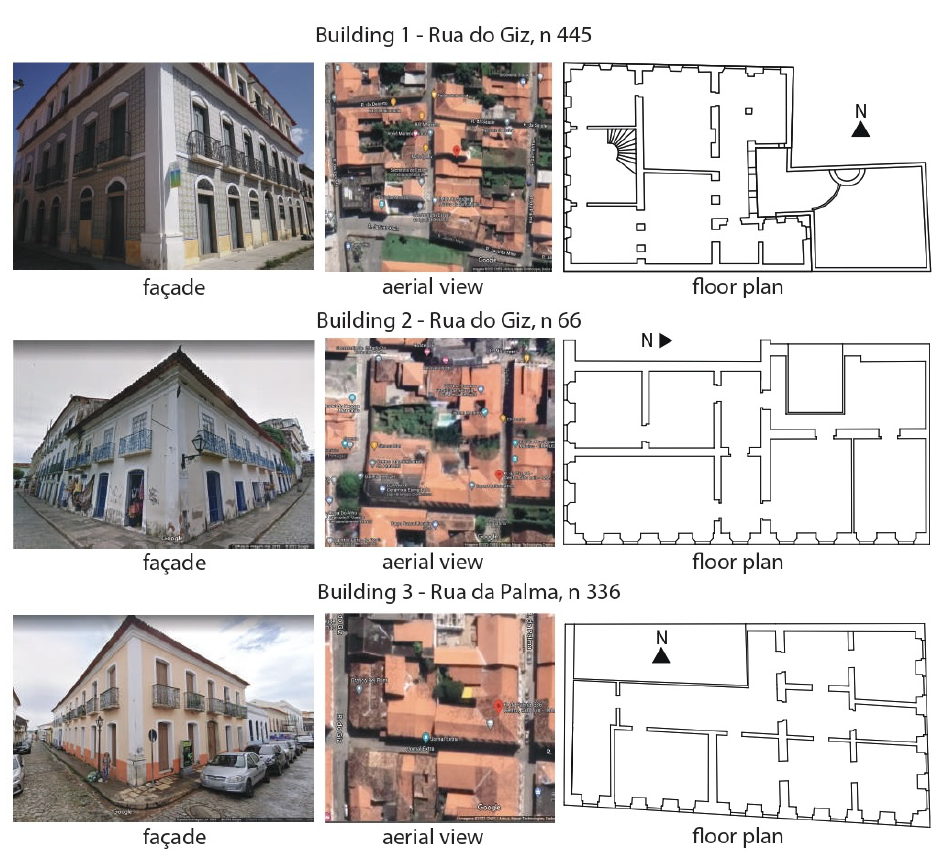
Figure 3. Case study